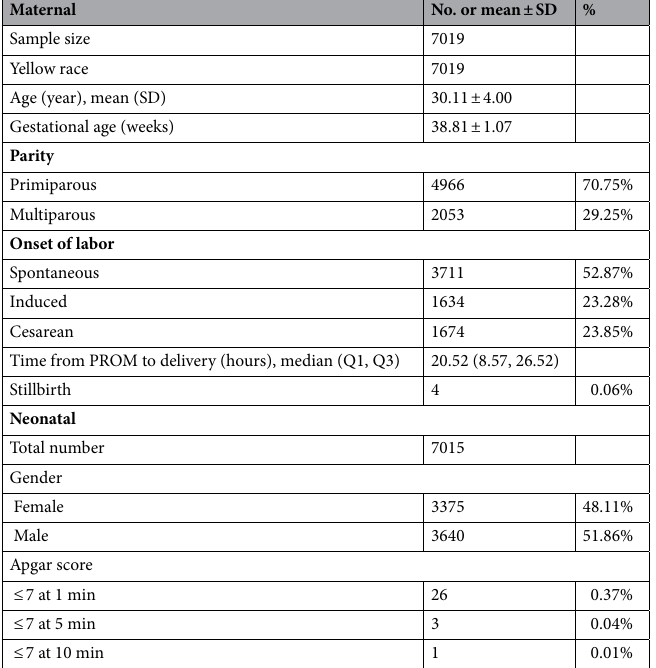
Table 1. Maternal and neonatal characteristics among pregnancies with and without PROM. GA gestational age, Q1 quartile 1, Q3 quartile 3. Percentages were tested with a χ 2 test. Medians were tested with a Wilcoxon rank sum test. a P value is significant at α = 0.05 level of significance.